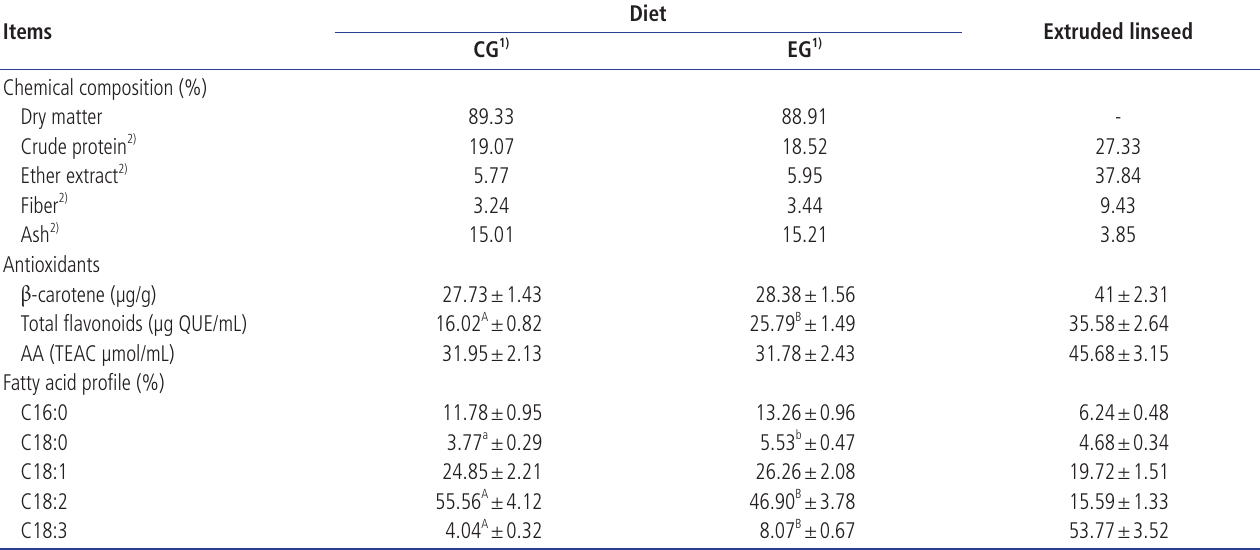
Table 1. Chemical characterization of extruded linseed and diets administered to laying hens of control and experimental group